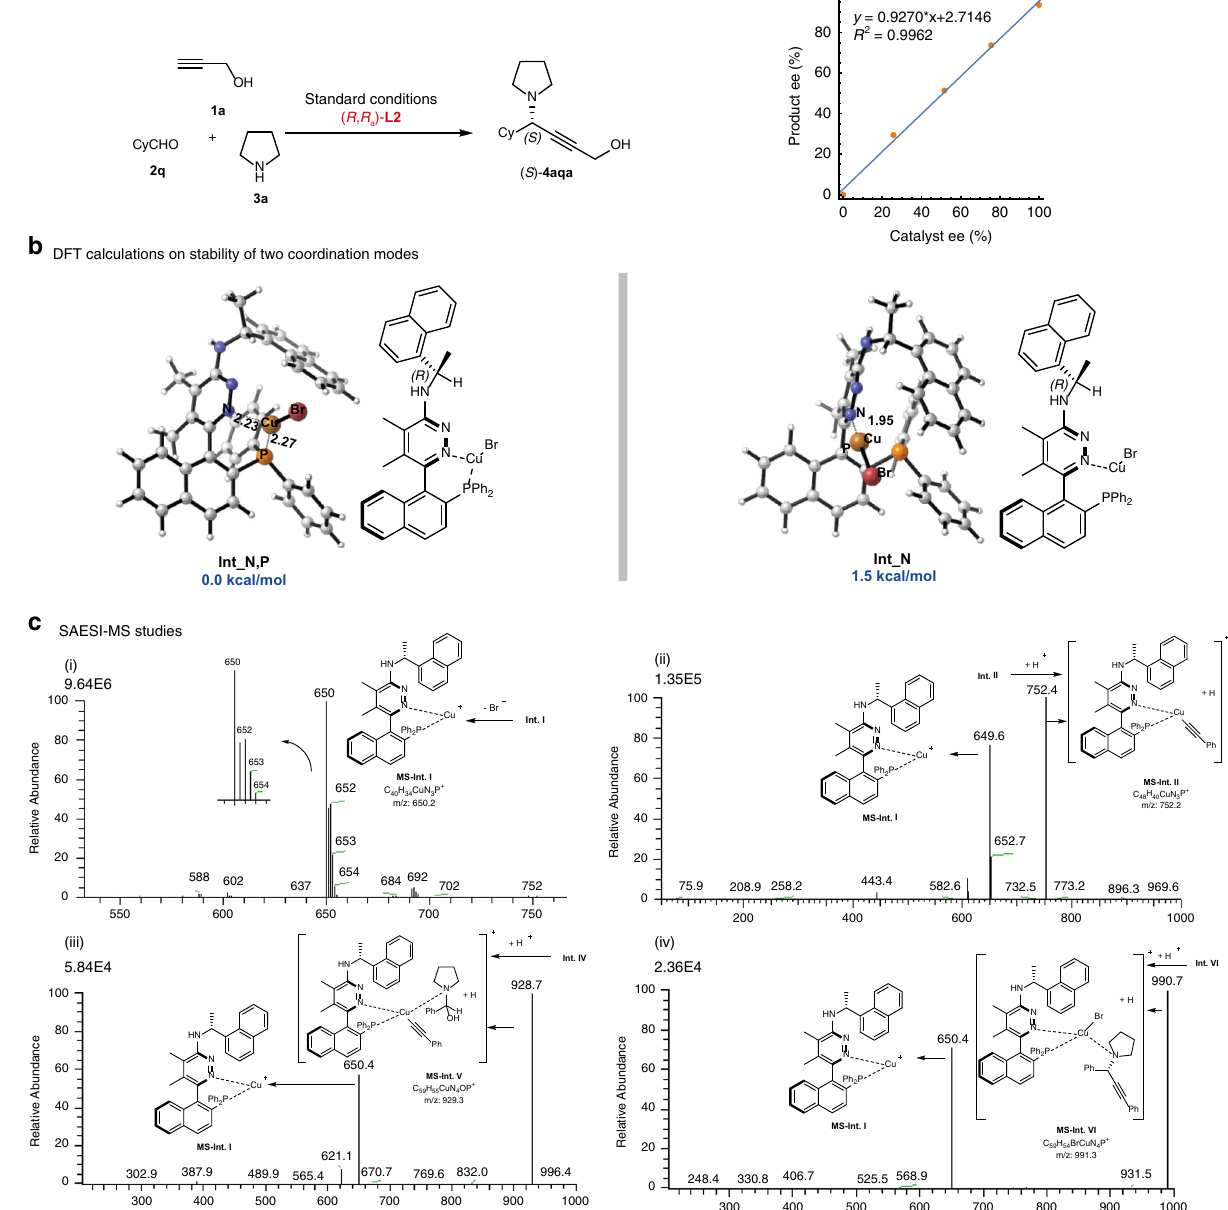
Fig. 5 Studies on reaction mechanism. a The linear effect. b DFT calculations on the stability of two coordination modes. The calculations were performed at the M06/SDD-6-311 ++ G(2d,p)/SMD(toluene)//M06/LANL2DZ-6-31G(d,p) level of theory at 273.15 K. The free energies Δ G are given with respect of Int_N,P . Bond lengths are given in angstroms. c SAESI-MS studies. (i) Expanded SAESI-MS spectrum showing the signal from m / z 540 – 760. (ii) SAESI- MS/MS spectrum showing the signal of MS-Int. II at m / z 752. (iii) SAESI-MS/MS spectrum showing the signal of MS-Int. V at m / z 929. (iv) SAESI-MS/ MS spectrum showing the signal of MS-Int. VI at m / z